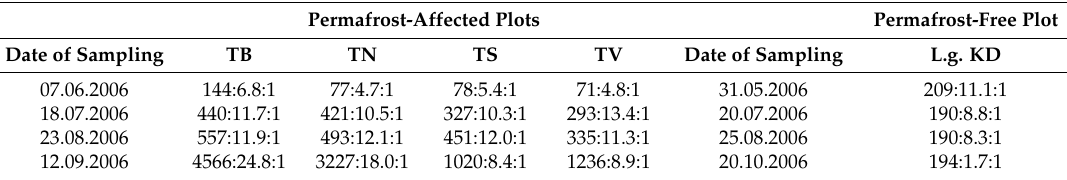
Table 3. Seasonal dynamics of the C:N:P ratio in the foliage of L. gmelinii from different sites in permafrost and permafrost-free terrain.